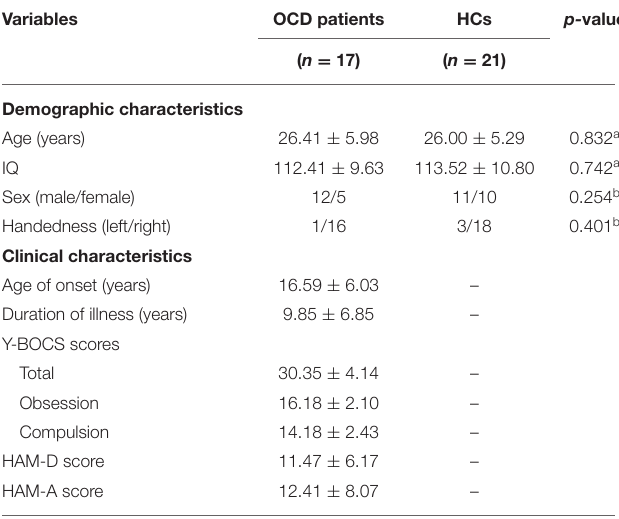
TABLE 1 | Demographic and clinical characteristics of patients with obsessive-compulsive disorder (OCD) and healthy controls (HCs).